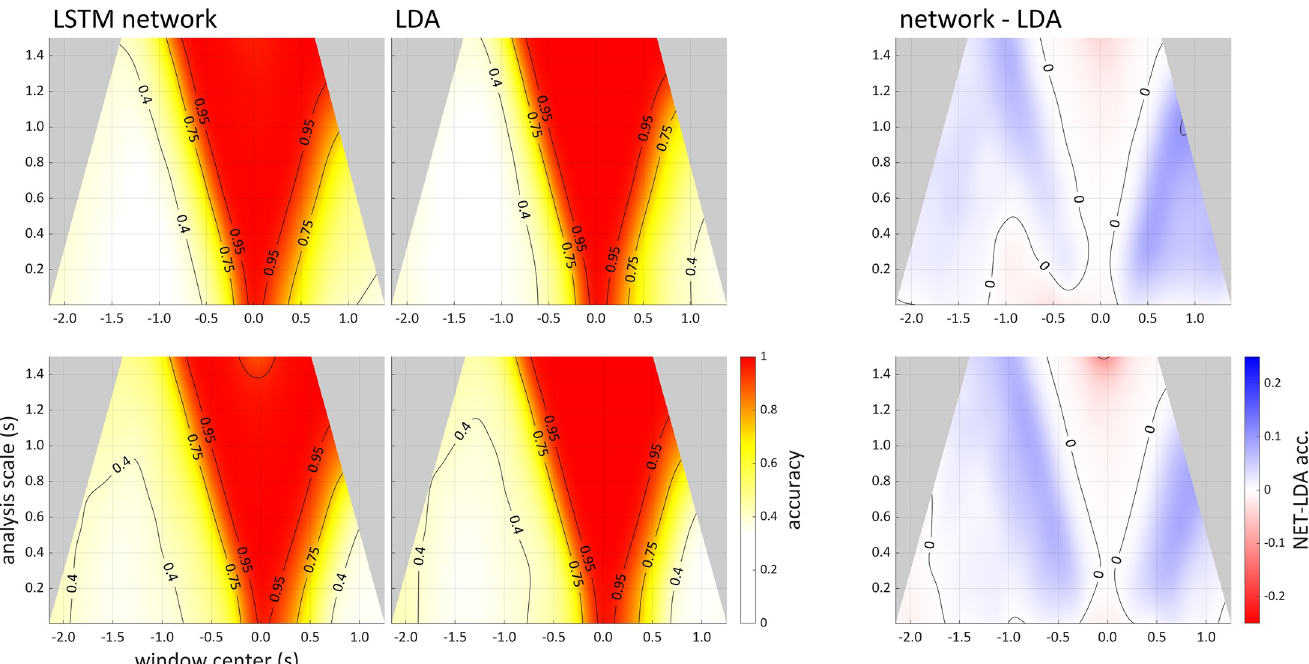
Fig 4. Scalographic comparison of neural network and LDA algorithms. Top and bottom panels are from participants sy01 and sy06 respectively in the syllable production dataset. Light gray areas are analyses which are not conducted because they would extend beyond the range of available signal. Left: scalograms of neural network and LDA analyses. Right: difference between neural network and LDA accuracies; where blue indicates that the neural networks achieved higher accuracy than LDA.